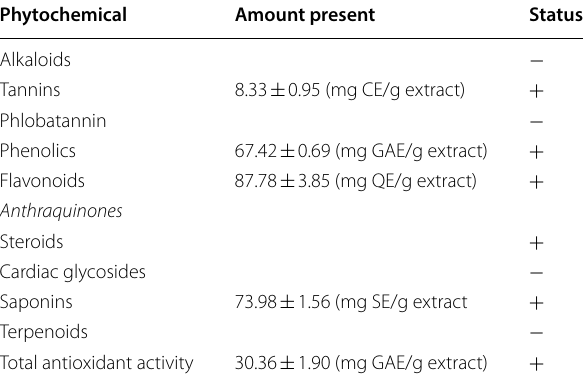
IC 50 = 7.09 mg/ml